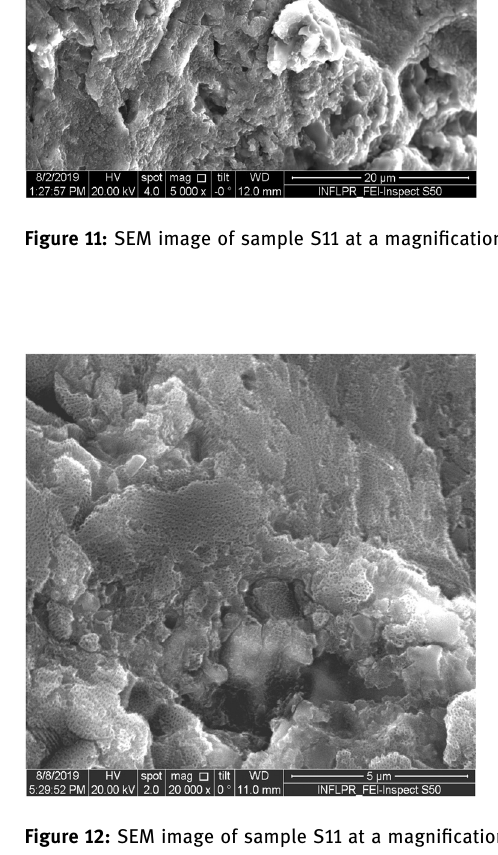
Figure 12: SEM image of sample S11 at a magni fi cation of 20k ×